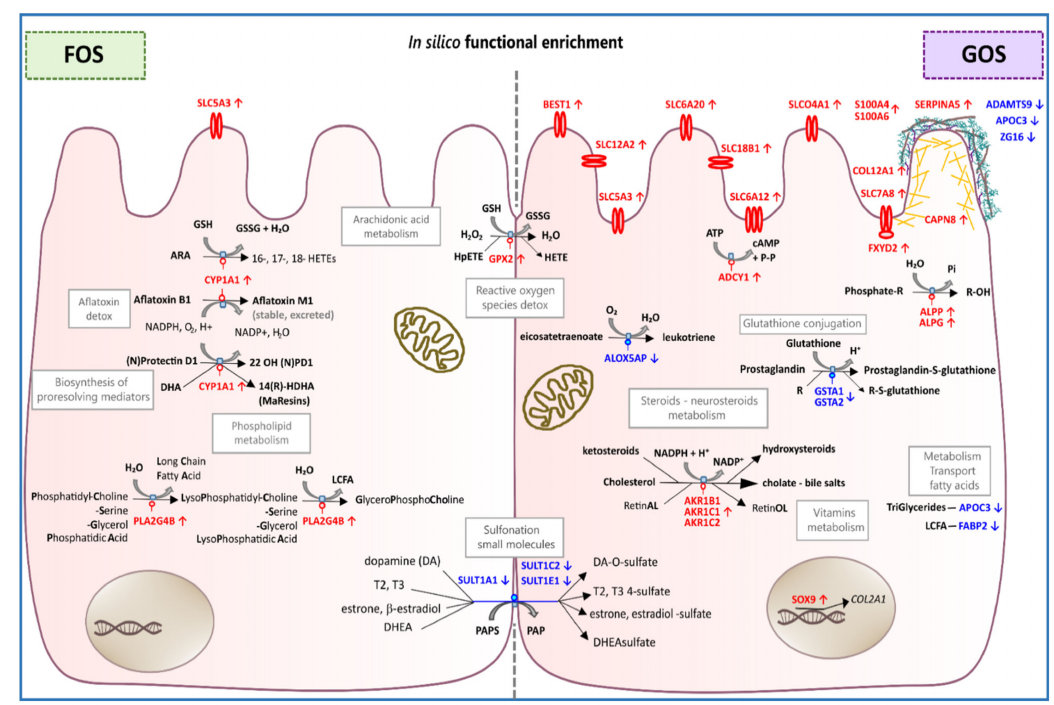
Figure 6. Summary of the pathway associations of the di ff erentially expressed genes (FDR p-adj. < 0.05, | FC | ≥ 1.5) identified as responding to the prebiotic oligosaccharides FOS or GOS in confluent colonic Caco–2 cells. Pathways were deduced from GO enrichment and KEGG analyses. Up-regulated functions are marked in red text and the down-regulated, in blue